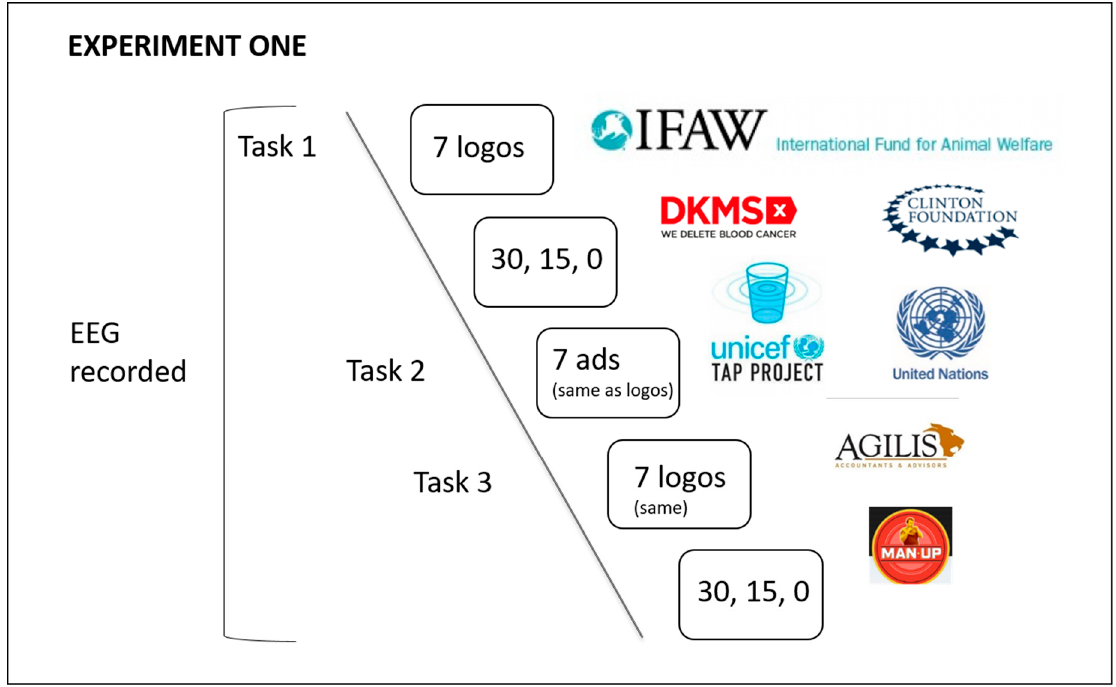
Figure 1. Experiment flow chart, tasks 1–3.